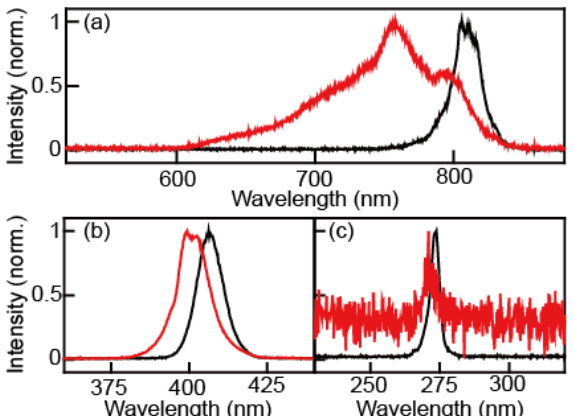
Figure 1. Spectral changes after plasma generation. ( a ) Fundamental source before (black) and after (red) the air plasma. ( b ) Second harmonic source before (black) and after (red) the air plasma. ( c ) Third harmonic source before (black) and after (red) the air plasma. Table 1. The peak wavelengths and FWHMs of the fundamental, second-harmonic, and third- harmonic fields measured before and after they interact with filamentation-forming air plasma. Center Peak (nm) FWHM (nm) Before After Before After Fundamental 805.2 750.4 25.6 98.3 Second Harmonic 402.6 397.1 10.3 10.9 Third Harmonic 269.1 267.3 4.3